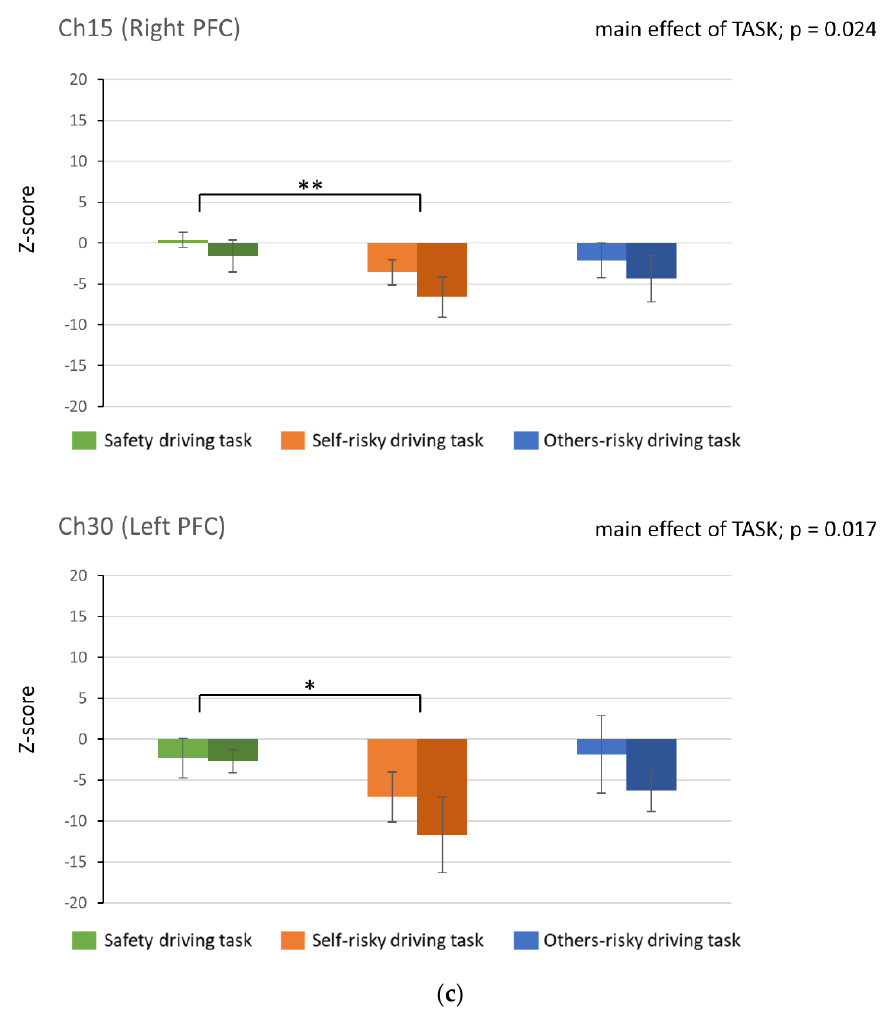
Figure 3. Results of brain activity by NIRS. ( a ) Channels that showed an interaction effect; ( b ) channels with a main effect of group; ( c ) channels with a main effect of task. The bars represent the mean ± standard error. In ( c ), the left side of the bar graph shows the high moral group, and the right side shows the low moral group. Statistics: repeated-measures two-factor ANOVA and Bonferroni correction were performed. * p < 0.05, ** p < 0.01.